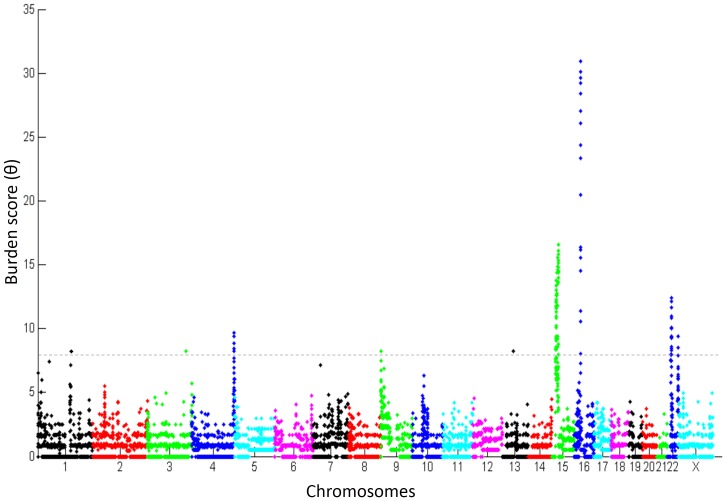
Whole-genome distribution of CNV burden.A Manhattan plot showing CNV burden among ASD subjects in 10 kb regions continuously distributed across the human genome. A dashed horizontal line indicate the burden score of 6.5 (0.995 quantile) that was used a threshold to determine the top ranked ASD susceptibility CNV loci.